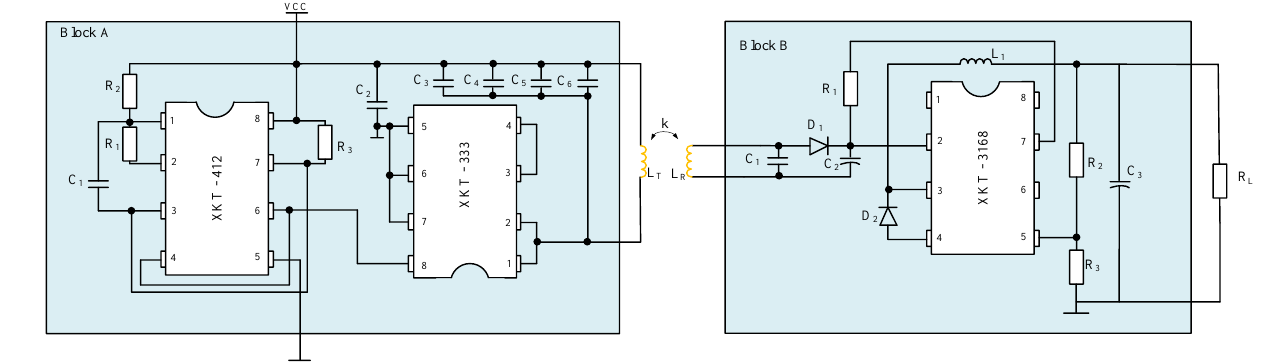
Figure 4. Tested WPT system with detailed diagrams of A and B blocks.